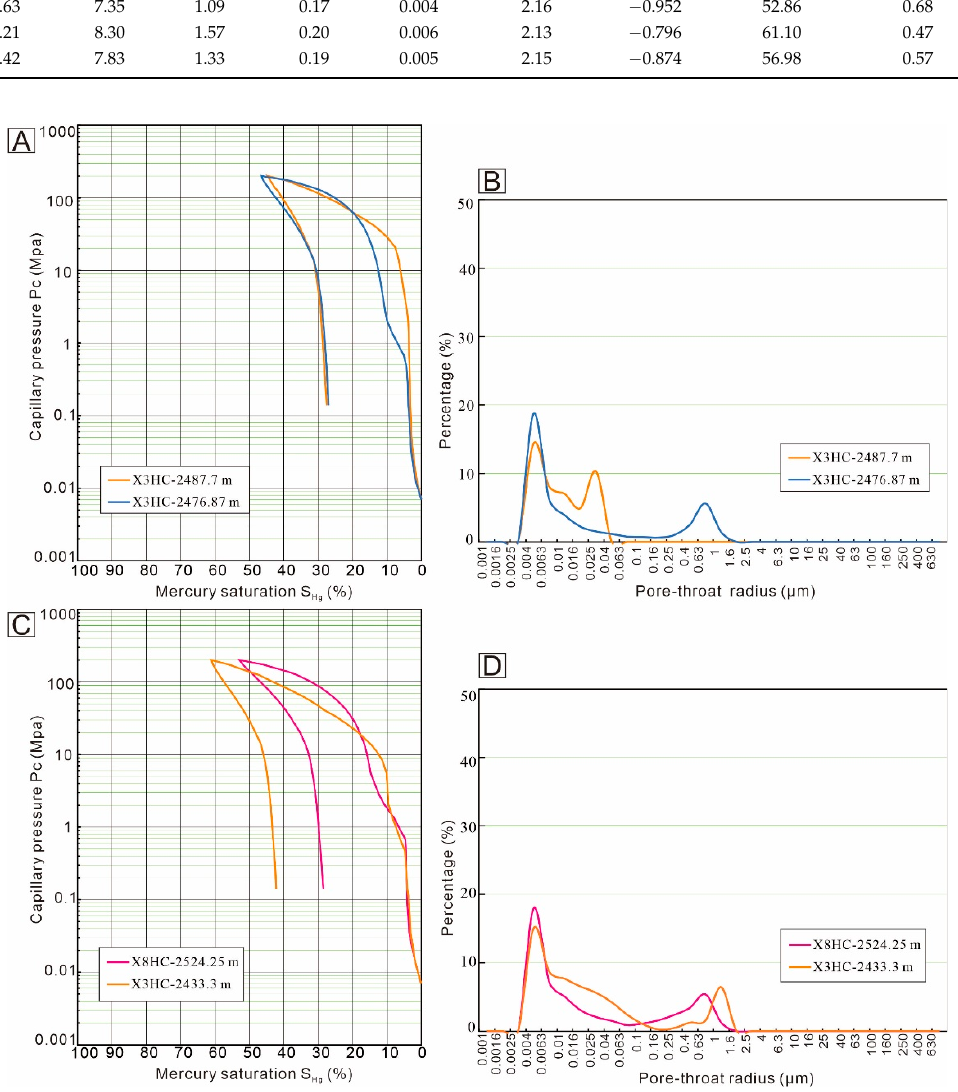
Figure 17. Mercury intrusion and extrusion curves and pore size distribution of AFMR ( A , B ) and CM ( C , D ). Table 3. Pore ‐ throat parameters of different lithofacies of FGSRs from mercury intrusion tests.